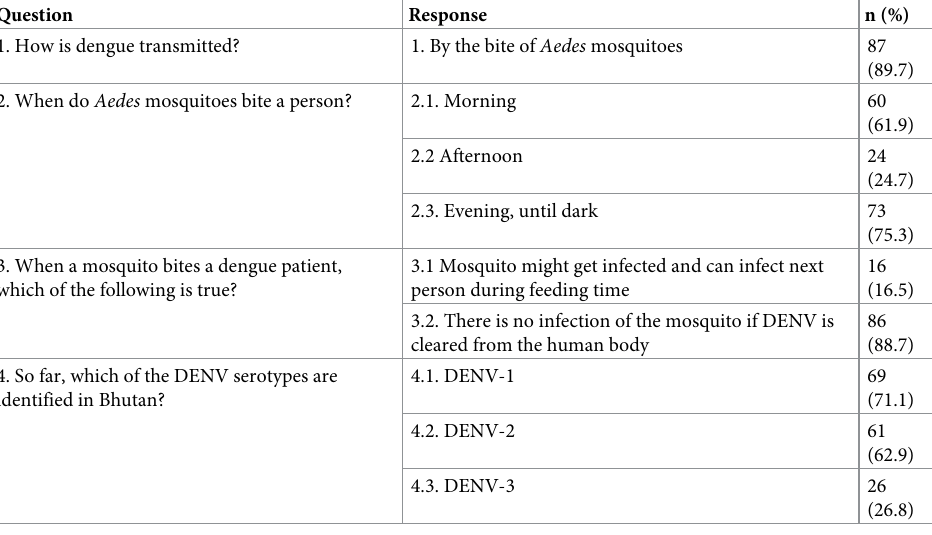
Table 2. Knowledge on the transmission of dengue (domain 1), Bhutan,